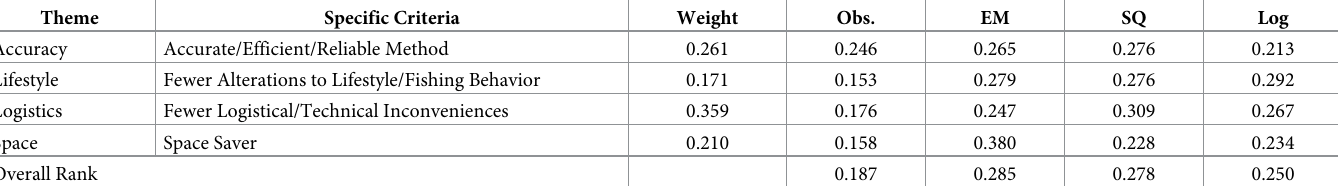
Table 7. Weighted criteria and overall rank of human observers (‘Obs.’), electronic monitoring (‘EM’), detailed logbooks (‘Log’), and the status quo (‘SQ’) alterna- tives for data collection at sea across four